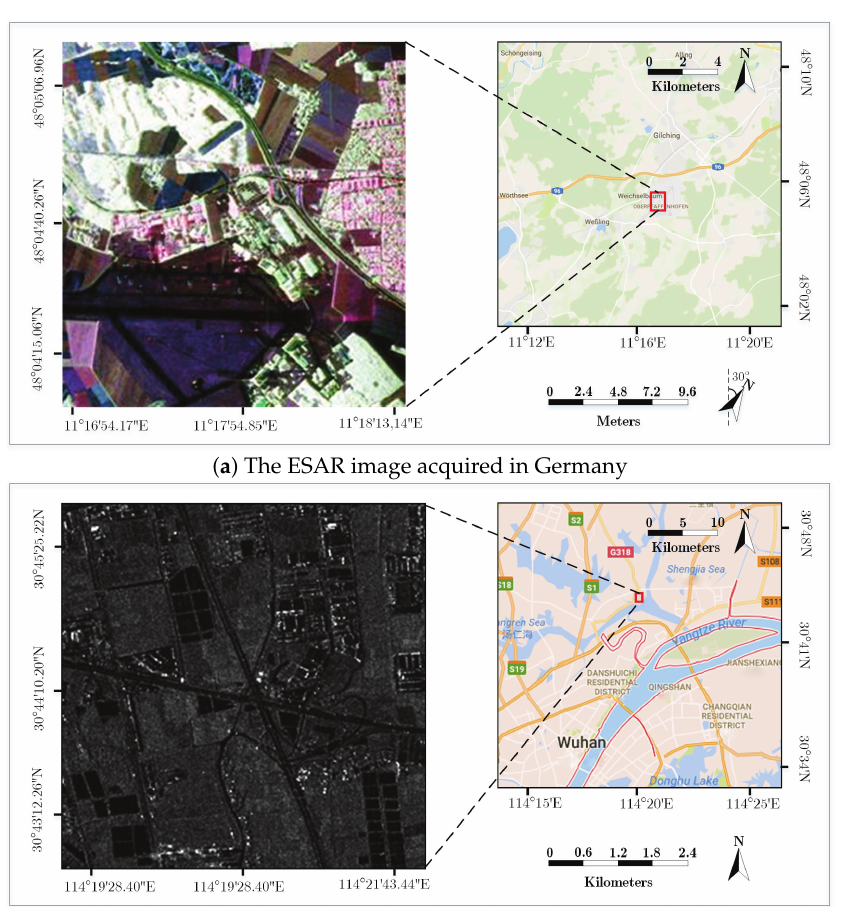
Figure 7. Experiment